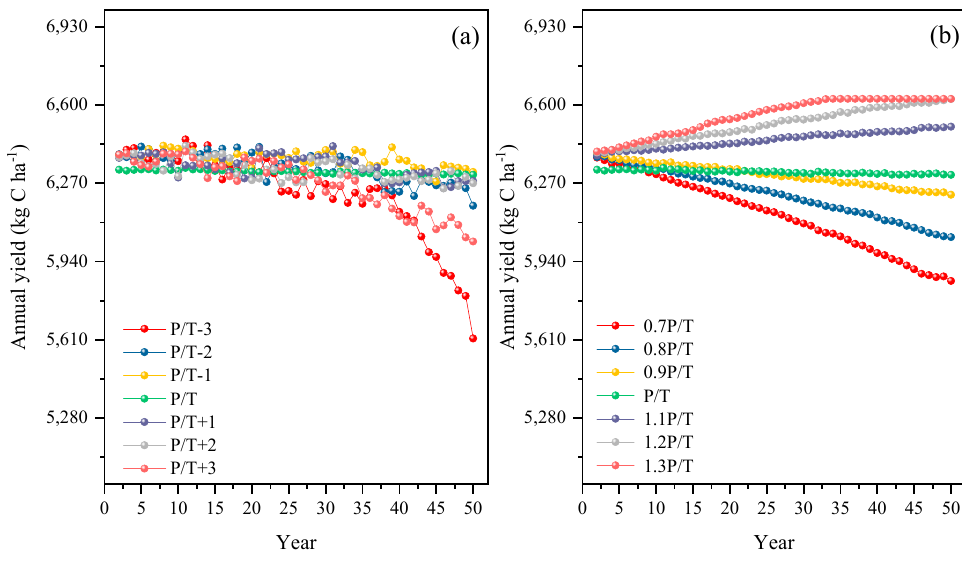
Figure 5. The 50-year effects on crop yields under temperature change scenarios ( a ) and precipitation change scenarios ( b ). P/T − 3: temperature decreased by 3 ◦ C; P/T − 2, temperature decreased by 2 ◦ C; P/T − 1: temperature decreased by 1 ◦ C; P/T: temperature unchanged; P/T+1: temperature increased by 1 ◦ C; P/T+2: temperature increased by 2 ◦ C; P/T+3: temperature increased by 2 ◦ C; 0.7P/T: precipitation decreased by 30%; 0.8P/T: precipitation decreased by 20%; 0.9P/T: precipitation decreased by 10%; P: precipitation unchanged; 1.1P/T: precipitation increased by 10%; 1.2P/T: precipitation increased by 20%; 1.3P/T: precipitation increased by 30%.